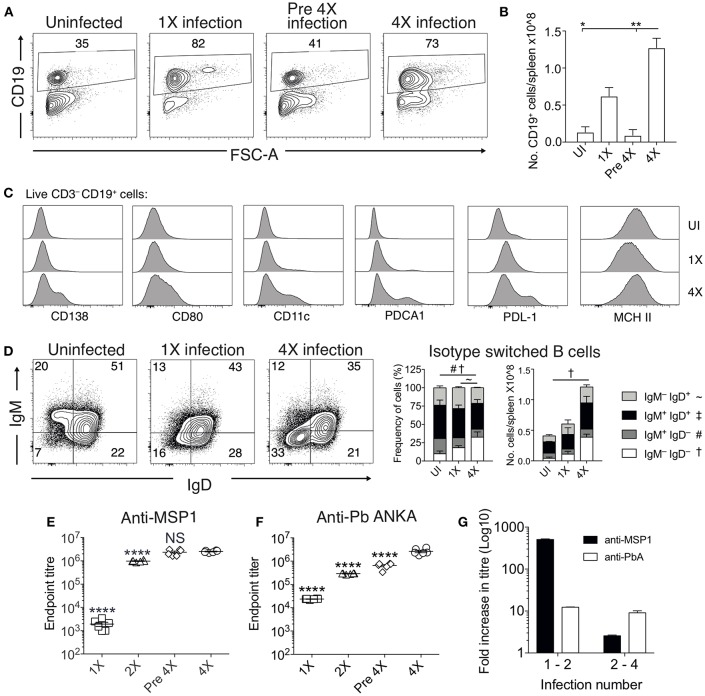
Anti-parasite IgG titres and atypical B cell populations are significantly increased in 4X infected mice. (A–G) Spleens and plasma were obtained from 4X infected and age-matched 1X infected C57BL/6 mice on day 8 post-infection (when 1X infected mice developed ECM), from pre 4X infected mice (minimum 30 days post-clearance of 3X infection) and from age-matched uninfected mice. (A) Representative flow cytometric plots and the frequencies of splenic CD19+ B cells, gated on live CD45+ CD3− cells. Numbers denote the percentage of cells within the gate. (B) Total numbers of splenic CD19+ B cells. (C) Expression of CD138, CD80, CD11c, PDCA1, PDL-1, and MHC II by CD19+ splenic B cells from uninfected, 1X infected and 4X infected mice. (D) Left, Representative flow cytometric plots (gated on live CD45+CD3−CD19+ cells), right, the frequencies and numbers of non-switched (IgM+IgD+ and IgM−IgD+) and switched (IgM+IgD−, and IgM−IgD−) splenic CD19+ B cells. The end point plasma titres of (E) anti- PbMSP119 and (F) anti-PbA IgG, with background titer from naïve mice subtracted. (G) Graphical representation of the fold change in Ab titer between 1X and 2X infected mice and between 2X and 4X infected mice. (B,D)
N = 2–6 per group, representative of two independent experiments (mean ± SD). Statistical analyses were performed with Kruskal-Wallis test with Dunn's multiple comparisons test *p ≤ 0.05, **p ≤ 0.01, and p < 0.05 denoted by #, ~, †for indicated groups. (E,F)
N = 6 per group, pooled from two independent experiments (mean ± SD). Statistical analyses were performed by one-way ANOVA with Tukey's multiple comparisons test, shown for 4X infected mice compared to each other group (****p ≤ 0.0001).